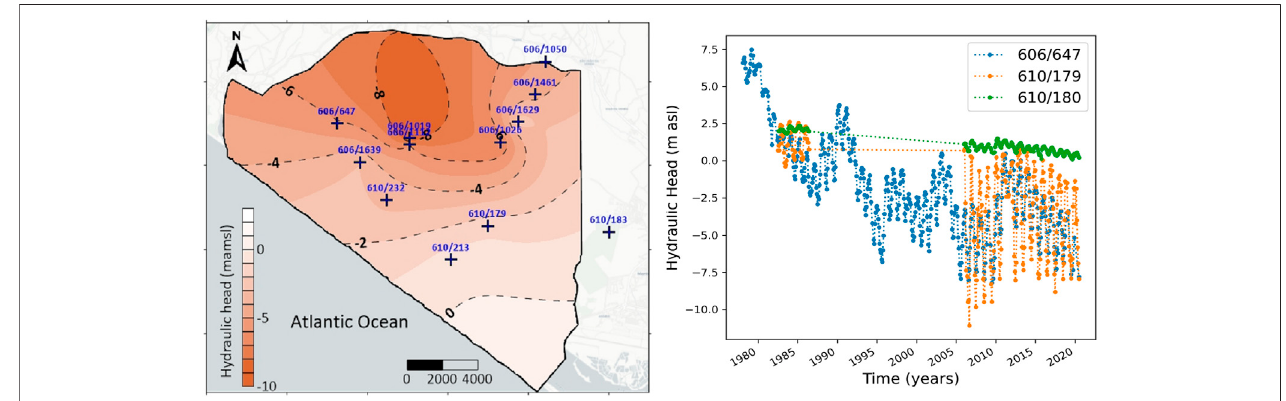
FIGURE 2 | Hydraulic head contours from semi-con fi ned aquifer, October 2018 (A) , Selected hydraulic head time series at piezometer locations 606/647 (semi- con fi ned), 610/179 (semi-con fi ned), and 610/180 (phreatic) (B)